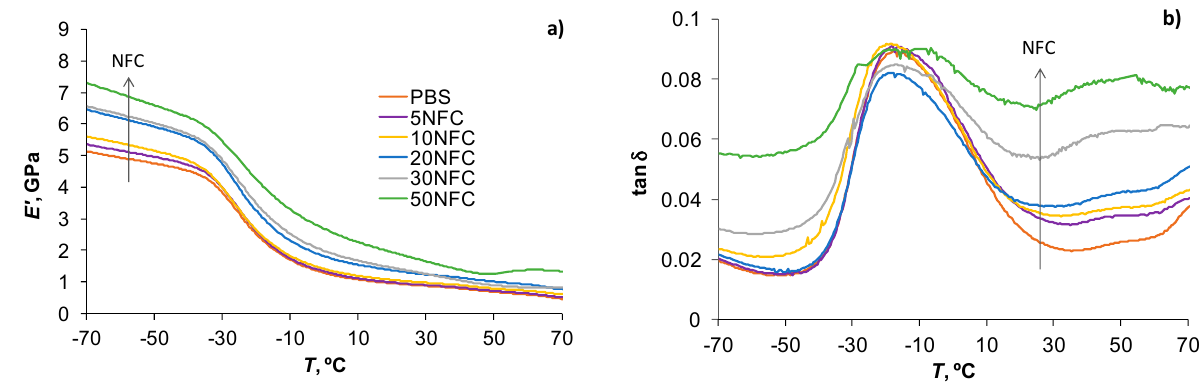
Figure 10. Storage modulus ( a ) and tan δ curves ( b ) for PBS/NFC samples aged under RH98%. The storage moduli of PBS, in both the glassy and rubbery regions, increased with the higher content of NFC. The reinforcement efficiency of NFC is compared in Figure 11 determined at different temperatures: − 70 °C (glassy state), 22 °C (room or service temperature that corresponds to the glass-to-rubbery transition region of PBS), and 70 °C (rubbery state). The slope of the linear dependences 𝐸 𝑐′ /𝐸 𝑚′ ( c is composite, m is matrix) is related to the reinforcement efficiency factor: the higher the slope, greater the filler contri- bution to the stiffness improvement of the polymer matrix [20,38]. Increased crystallinity of composites could also contribute to the E ’ increase [36,41]. Although this is not the case for this study, since the crystallinity of PBS is only slightly and negatively affected by NFC (Table 2). The rubbery moduli are, to a great extent, correlated with the degree of interac- tion between the polymer and NFC, while the reinforcing effect of the filler is eliminated. Thus, an increasing 𝐸 𝑐′ /𝐸 𝑚′ dependence for 70 °C (up to 60% improvement for 50NFC), although with a much lower slope than that for − 70 °C, indicates a reasonably high inter- action degree at the PBS-NFC interface. Almost a 3-fold increase in the rubbery E ’ (70 °C) is obtained with the addition of NFC. Identical improvements of E ’ are also observed at 22 °C, i.e., in the transition region. Figure 11. Relative storage moduli as a function of volume content of NFC of the reference and RH98 samples determined at − 70, 22, and 70 ° C . Solid and dotted lines are approximations. The glassy and rubbery storage moduli of PBS/NFC were only slightly affected by ageing in a humid environment, resulting in minor decrease in the slopes of the depend- ences 𝐸 𝑐′ /𝐸 𝑚′ versus NFC content for both characteristic temperatures (Figure 11, shown by errors). At the same time, a great decrease in E ’ of aged samples is observed at 22 °C. This could be explained by the higher plasticization effect of absorbed moisture in this